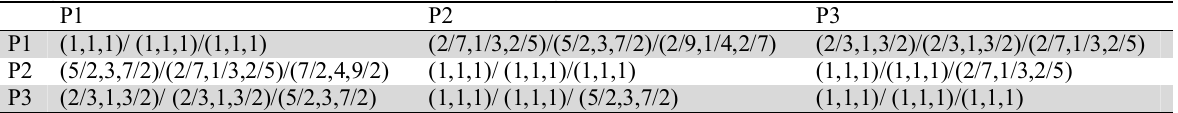
Linguistic Evaluations of Alternatives According to AE/RPW/TI